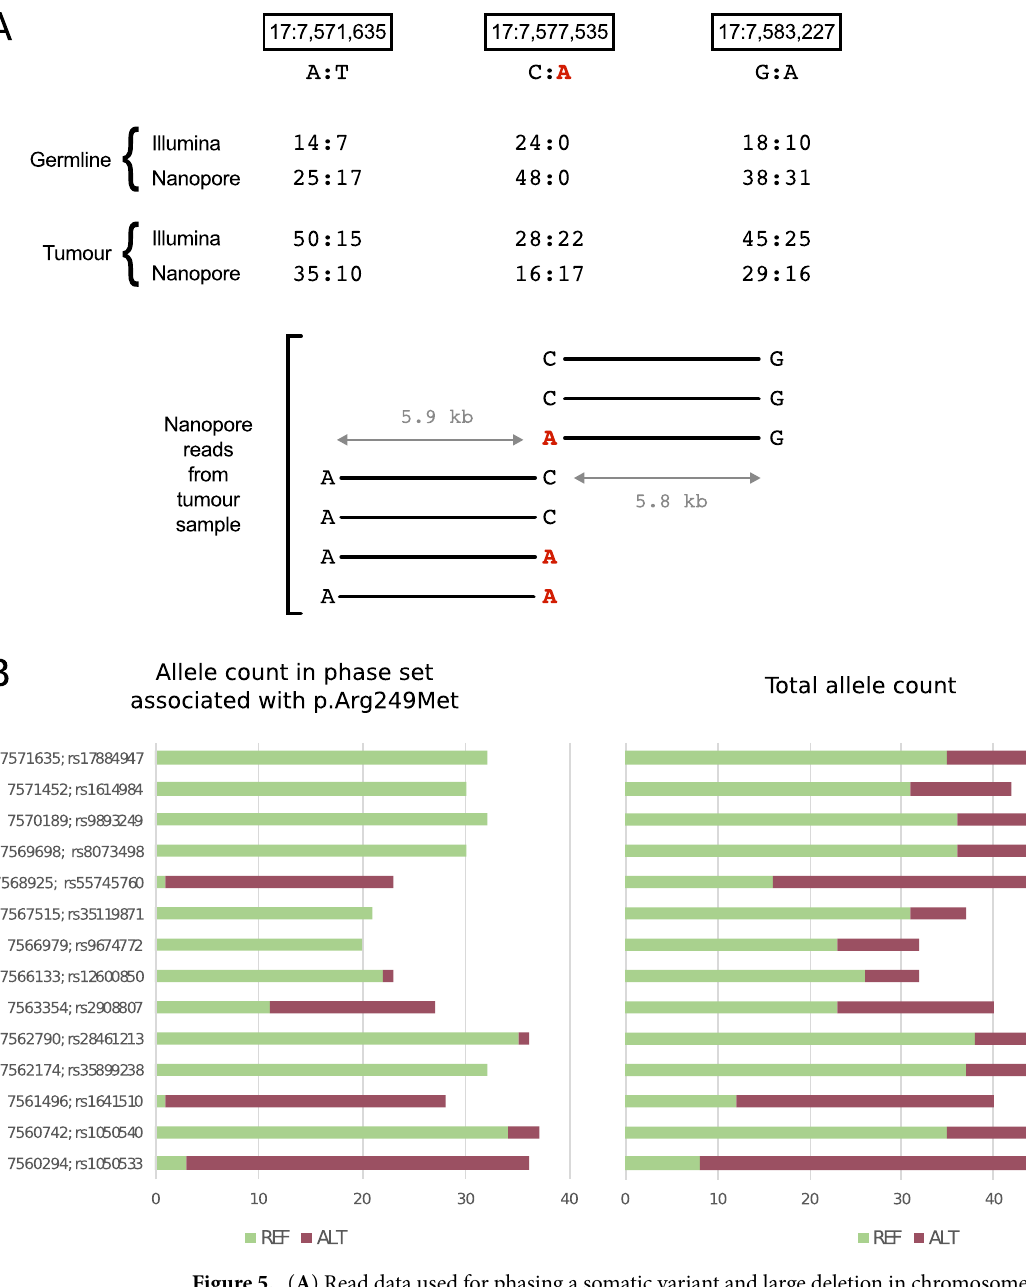
Figure 5. ( A ) Read data used for phasing a somatic variant and large deletion in chromosome 17. Top half: The locations of two heterozygous SNPs (left and right) and somatic single nucleotide variant, p.Arg249Met, (centre) are shown. All three lie within the region covered by the deletion. Base counts are shown reads from both samples run on both platforms (for Nanopore, the reads mapped with minimap2 were used). The somatic variant is highlighted in red. Bottom half: 7 reads spanned from the site of the somatic variant to one or other of the heterozygous SNPs. Each read is shown as a horizontal bar with the base calls at the relevant sites annotated. The approximate distance between the sites is indicated by the grey arrows and text. ( B ) Counts of REF (green) and ALT (dark red) alleles at sites of germline heterozygous SNPs within the range of the phase set covering 17:7,577,535 and in which the somatic mutation p.Arg249Met is seen. Allele counts are given for only reads within the phase set (and assigned to the same haplotype), as given by WhatsHap (LHS), and for all reads covering the position (RHS). The chromosome 17 coordinates and SNP id are given on the extreme left. In all but one case the vast majority of the reads in the phase set match the majority (i.e. non-deleted) allele in the total allele count. rs2908807 is the exception since the allele count in the phase set is much more even. Although this phase block extends ~ 17 kb in the 5 ′ direction from the somatic mutation, this does not reach the distal breakpoint of the deletion, which is ~ 166 kb away. A snapshot showing the extent of the phasing blocks in shown in Supplementary Fig.